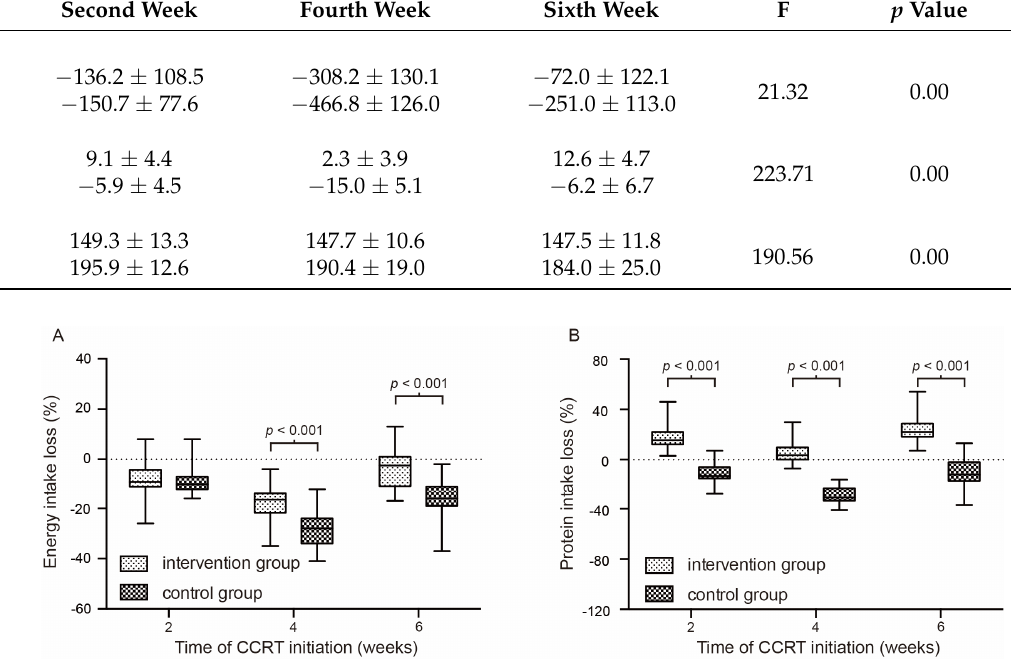
Table 2. Comparison of calories and proteins intake between the two groups (Mean ± SD).